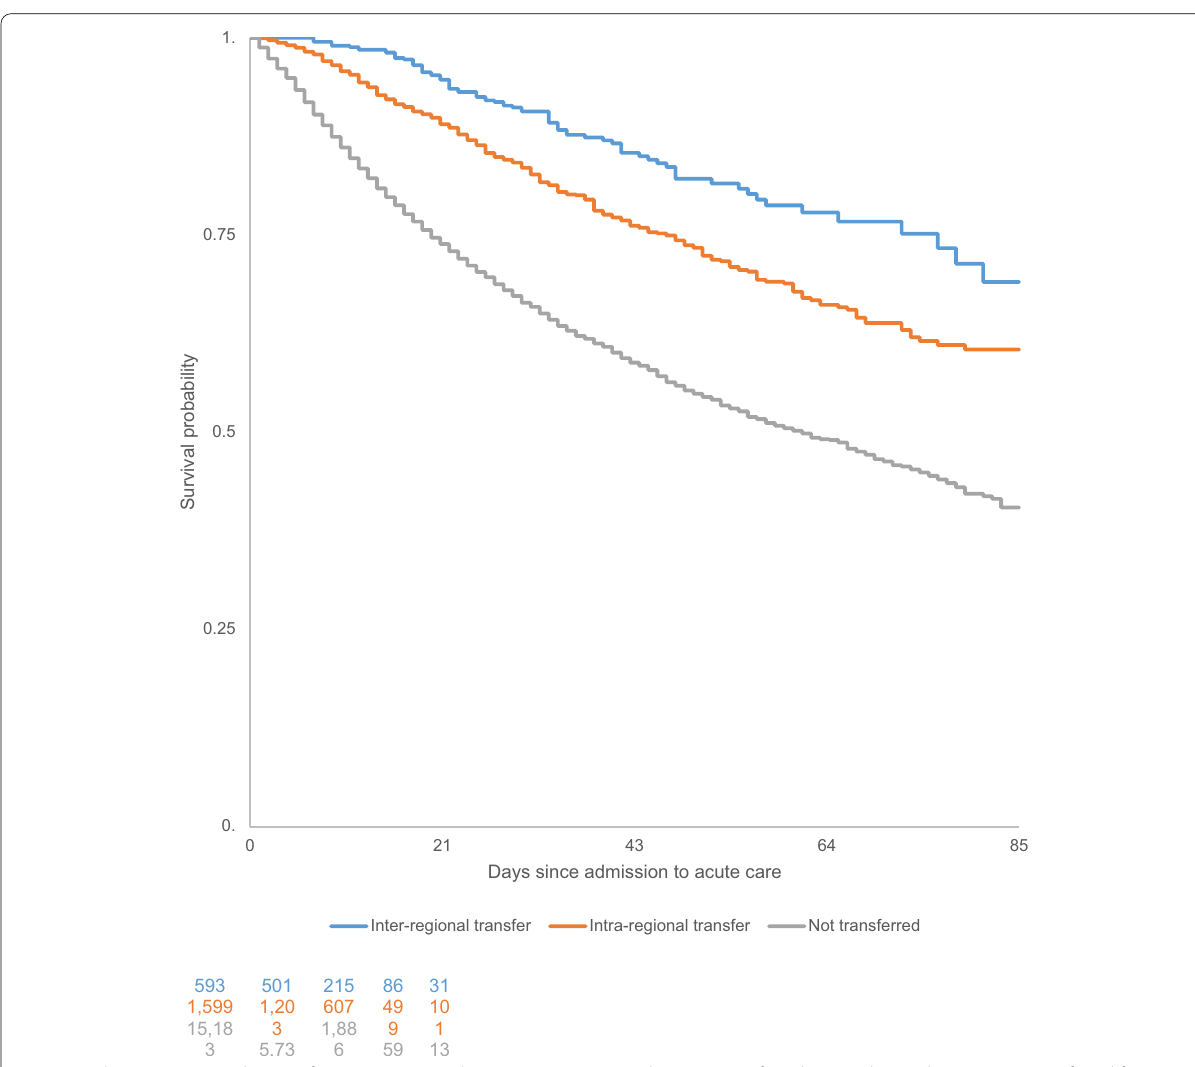
Fig. 2 Kaplan–Meier survival curves for ICU patients with COVID‑19 in France who were transferred versus those who were not transferred from 1 March to 21 June